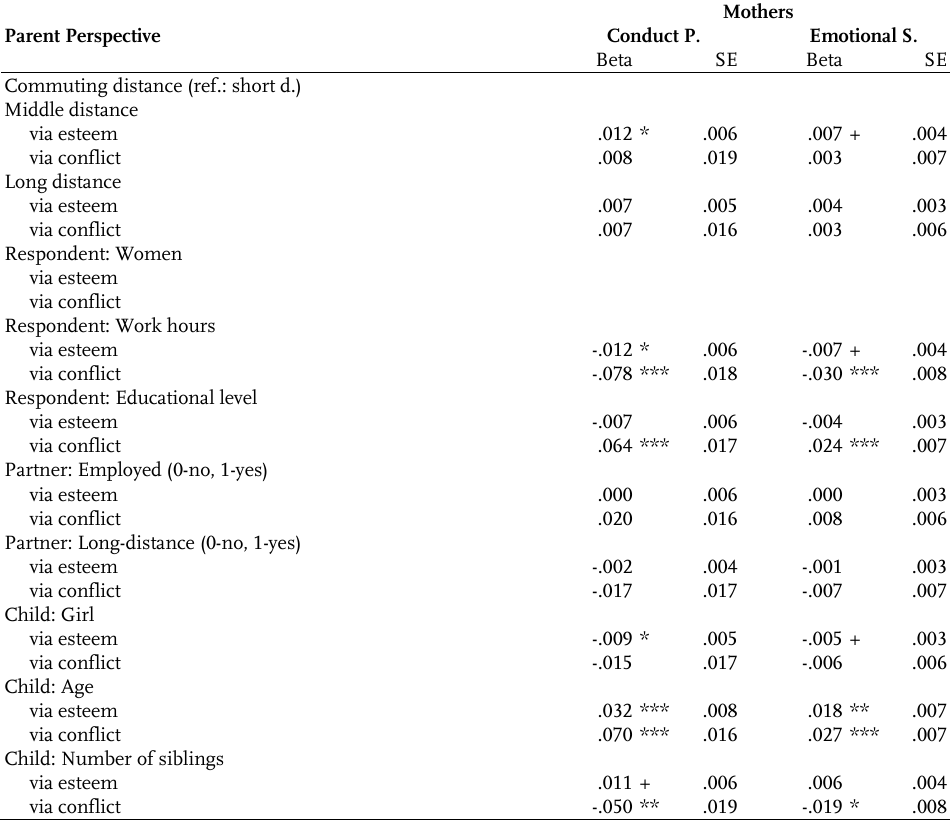
Table B : The indirect association between parental long-distance commuting and child well-being via the parent-child relationship (evaluated by the parent) (continued) Mothers Parent Perspective Conduct P. Emotional S. Beta SE Beta